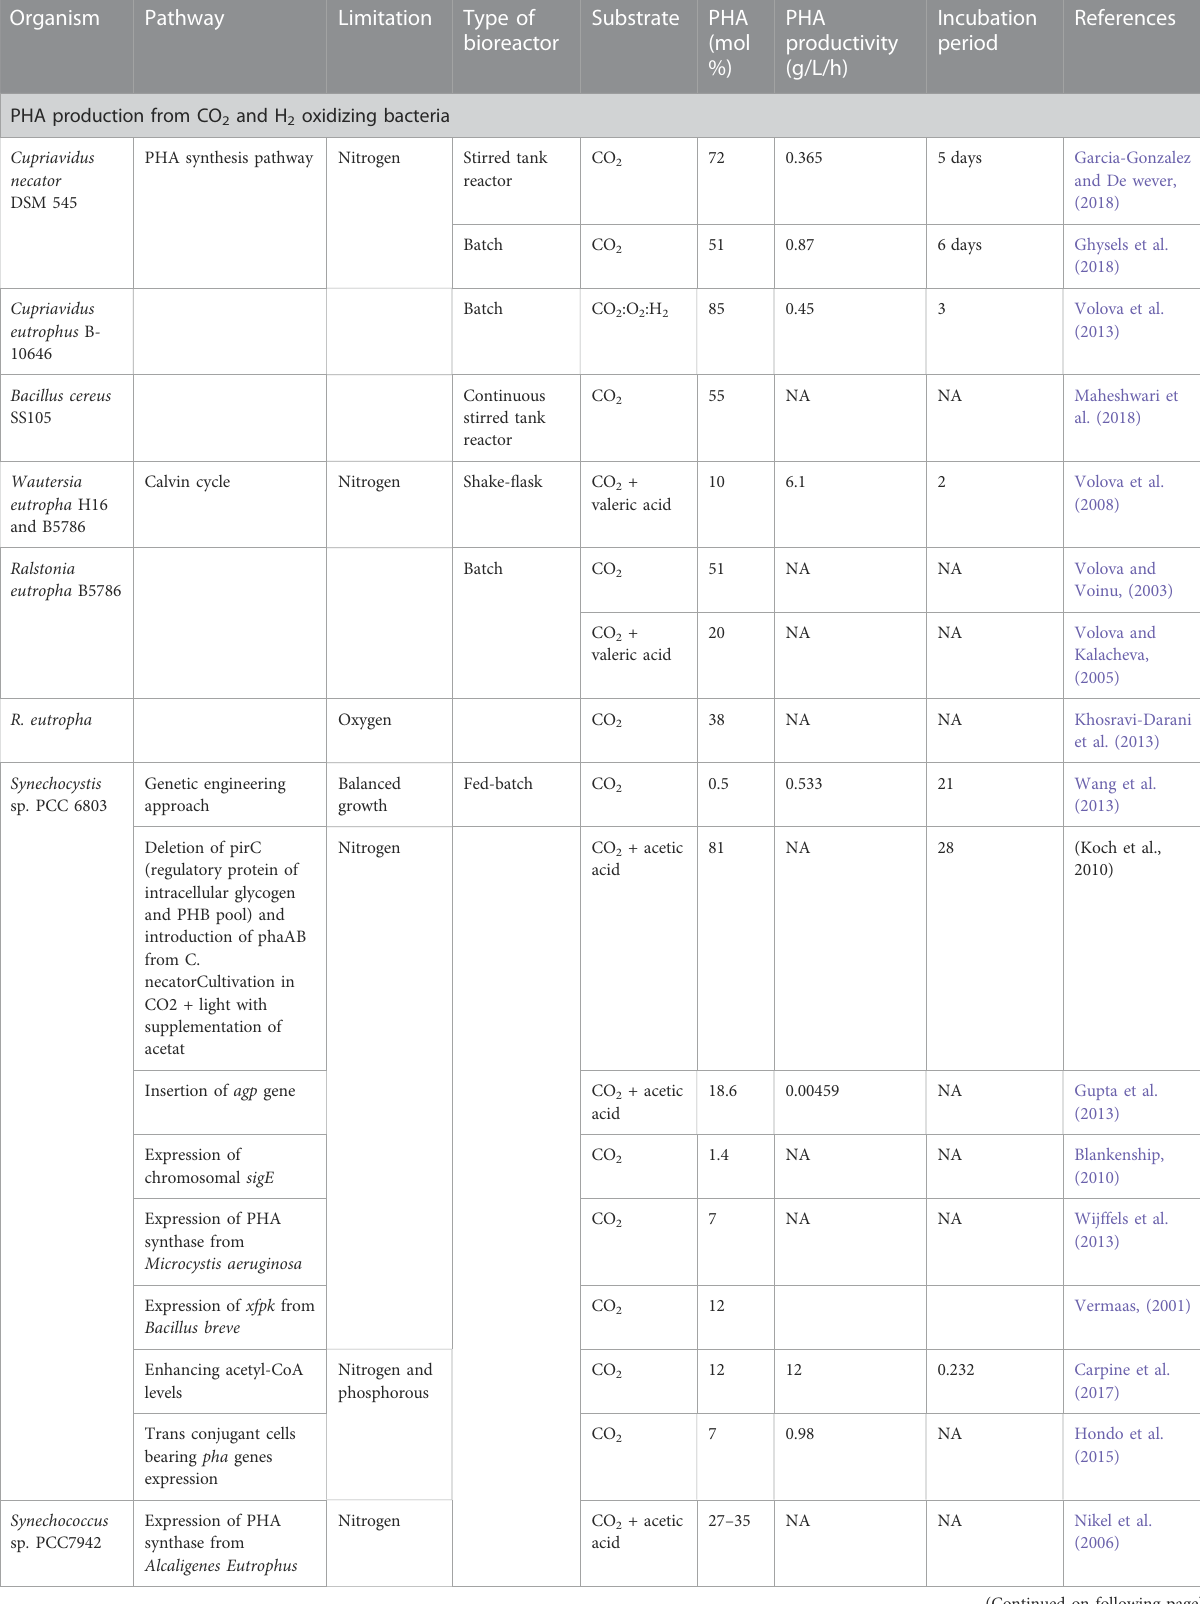
TABLE 1 Polyhydroxyalkanoates production from CO 2